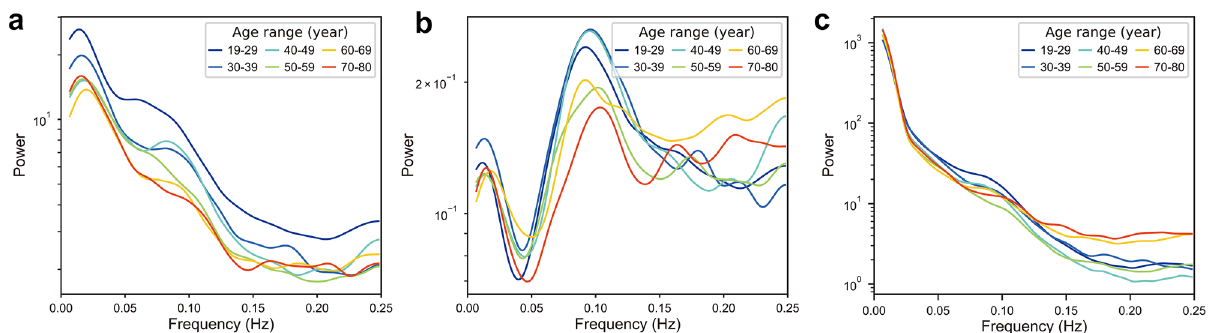
Figure 4. The power spectrum of GS. ( a ) Original data. ( b ) De-convolved data. ( c ) Data without noise regression. Each line represents the average power spectrum of subjects every 10